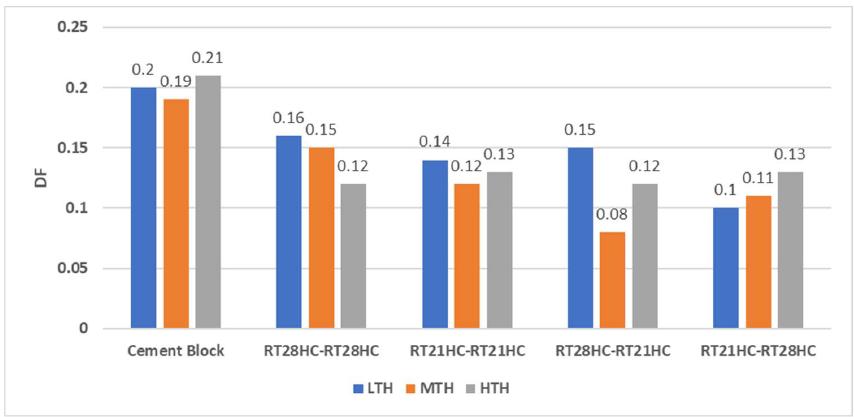
Figure 15. DF values for cement-block-only samples and samples with integrated PCMs.